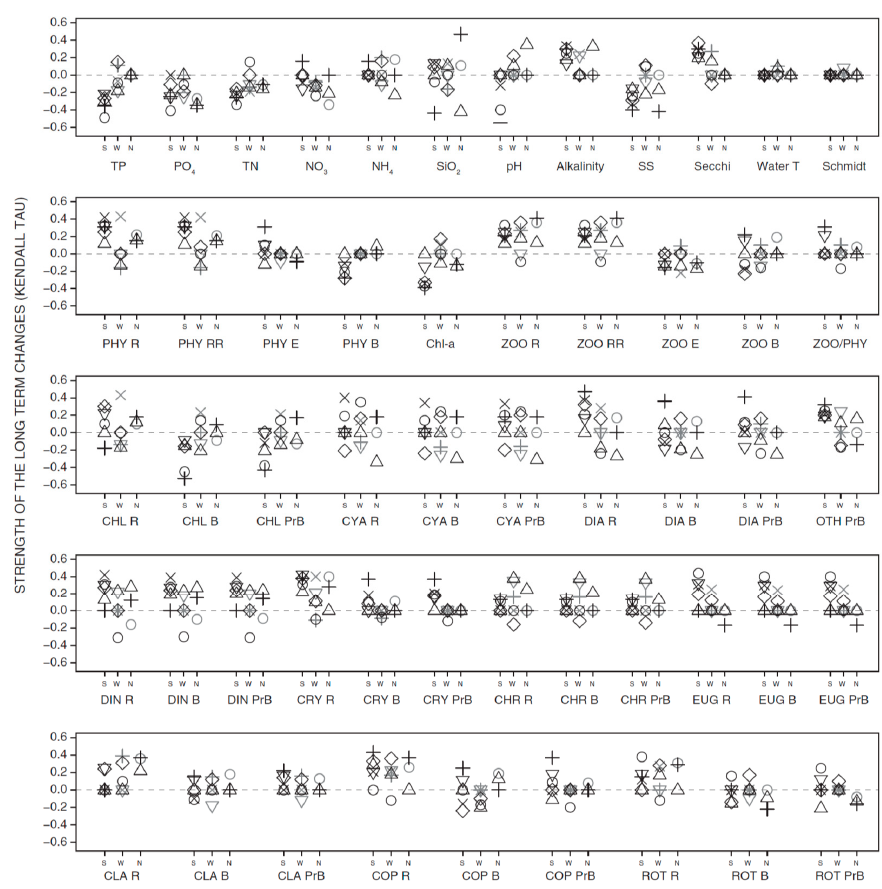
Figure 4. Summary of the monotonic long ‐ term trends in lake physico ‐ chemical and plankton variables. Trends were analysed using Kendall correlations and the magnitude of the temporal correlation was reported in Y axis in each panel. Lakes were grouped into S, W and N lakes. Plotting symbols represent a unique lake in each lake group for different variables, and grey colour represents deep lakes (mean depth < 3.5 m). The Kendall correlation is taken as 0 for the insignificant tests. R, richness; RR, rarefied richness; E, evenness; B, biomass; PrB, proportional biomass; CHL, Chlorophyta; CYA, Cyanobacteria; DIA, Bacillariophyceae; OTH, all phytoplankton groups excluding CHL, CYA, DIA; CRY, Cryptophyta; CHR, Chrysophyta; EUG, Euglenophyta; CLA, Cladocera; COP, Copepoda; ROT, Rotifera. Results of separate analyses for each season are given in the Figures A6–A8.